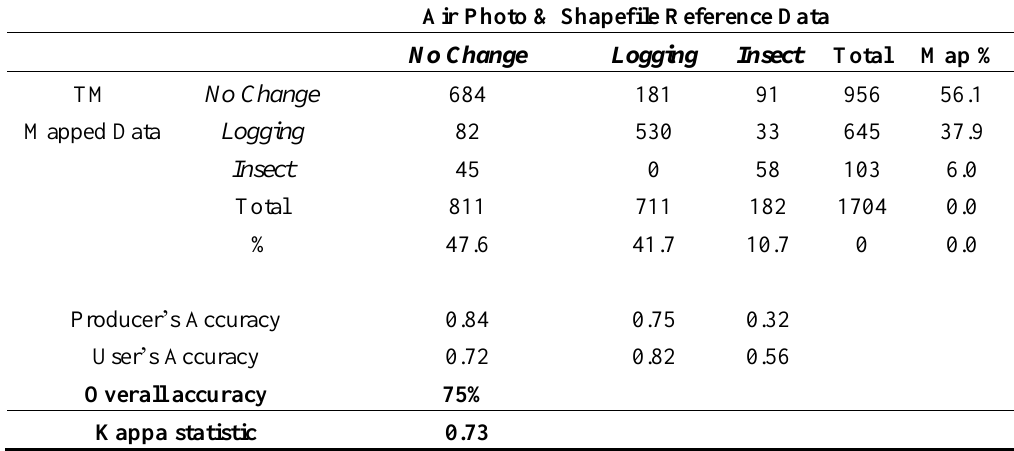
Table 2. Validation statistics (Iteration 8 of 20), ensemble thresholding for logging (∆DI > −7000) and insect outbreak ( p < 0.15).